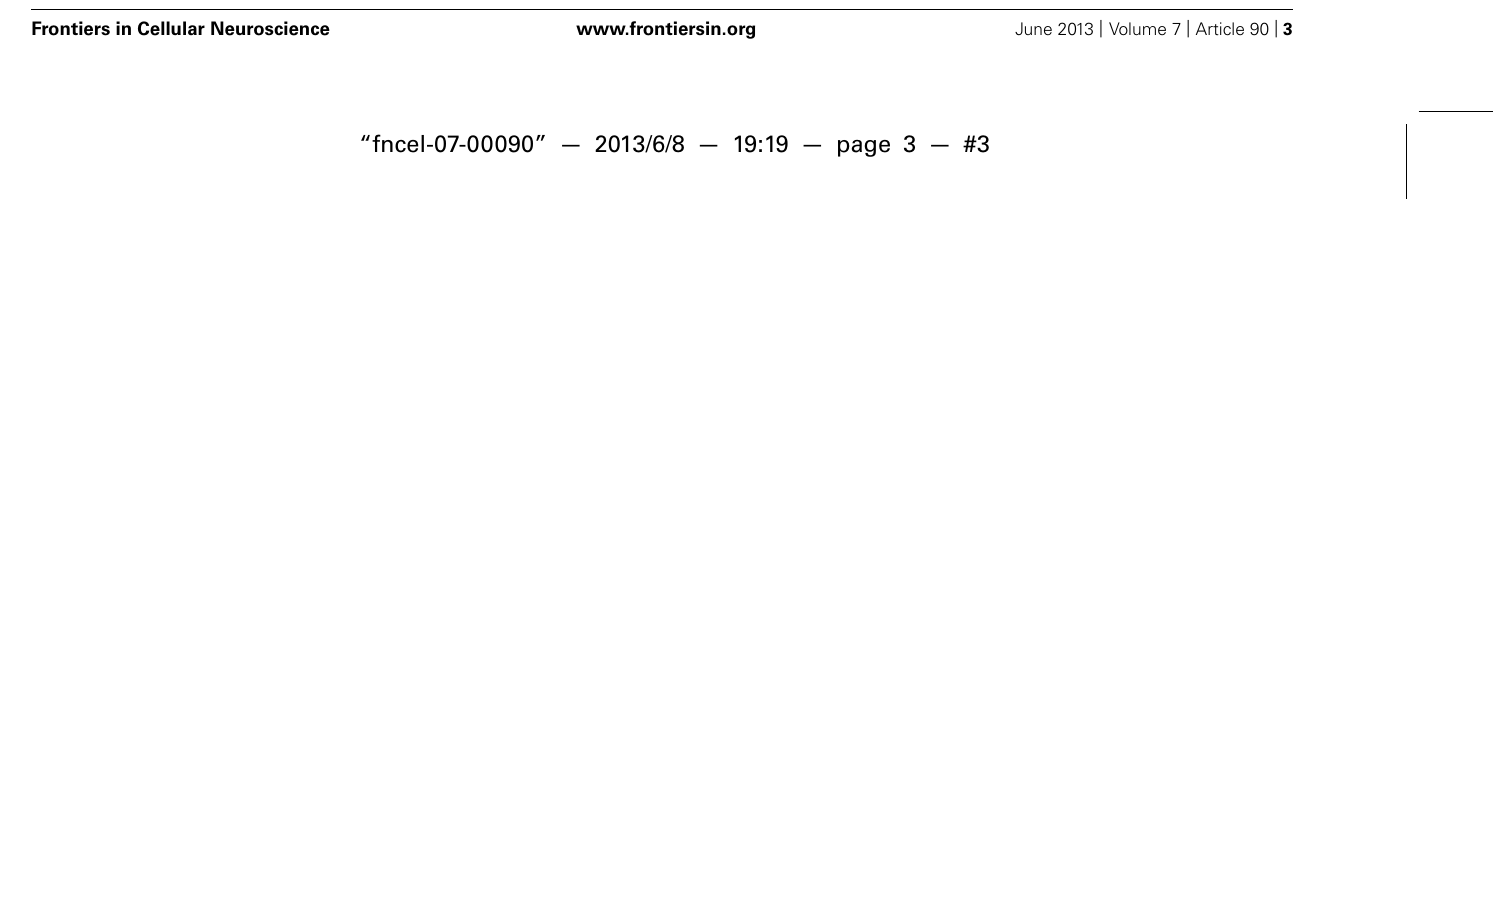
triphosphate; DA, deaminase; GMP, guanosine monophosphate; GTP, guanosine triphosphate; HGPRT, hypoxanthine-guanine phosphoribosyltransferase; HL, hydrolase; IMP, inosine monophosphate; NP, nucleoside phosphorylase; PRPP, 5-phosphoribosyl pyrophosphate; SAH, S -adenosylhomocysteine; SAM, S-adenosylmethionine; XMP, xanthosine monophosphate; XO, xanthine oxidase. Reprinted by permission fromYao etal.